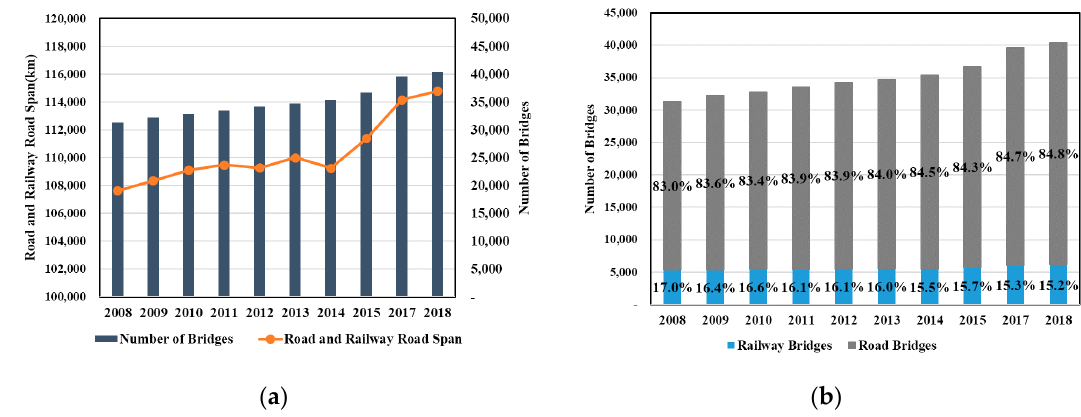
Figure 1. Evolution of transportation infrastructure in Korea: ( a ) total length and bridge inventory; ( b ) proportions of roadway and railway bridges.